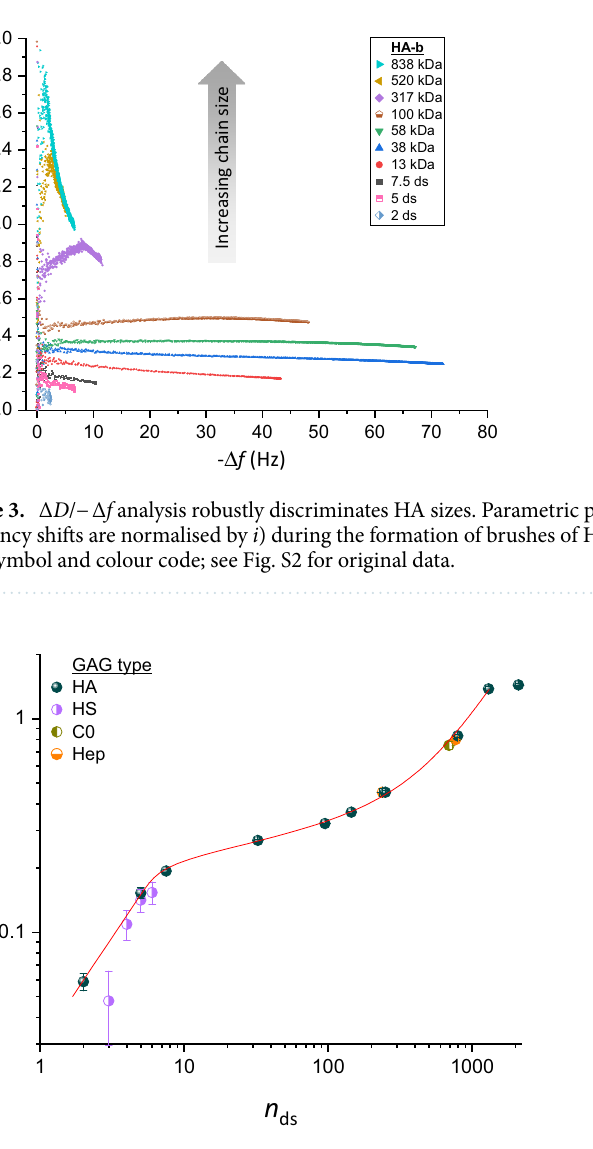
Figure 4. Standard curve for sizing HA, and extension to other GAG types. Double logarithmic plot of Δ D /− Δ f ( i = 3; frequency shifts are normalised by i ) at low GAG surface density (− Δ f = 2.5 Hz) as a function of the mean number of disaccharides per GAG-b chain, n ds (mean ± 5%, except for oligosaccharides which were taken to be pure in size, see Table 1). Data for all size-defined HA-b samples (blue spheres) represent mean ± standard error of the mean from between two and four independent experiments (see Fig. S4 for details). The data for HA up to n ds = 1300 are faithfully reproduced and interpolated by Eq. (1) (red line), representing the standard curve for GAG sizing. Data for size-defined preparations of other GAG types (half-filled circles; see Fig. S6 for original data) are also seen to map onto the standard curve: four heparan sulfate (HS-b; violet) oligosaccharides, two heparosan (Hep-b; orange) and one chondroitin (C0-b; dark yellow) polysaccharide. Symbols and error bars for non-HA GAGs represent individual experiments with the mean ± standard deviation time-averaged over − Δ f values ranging between 2 and 3